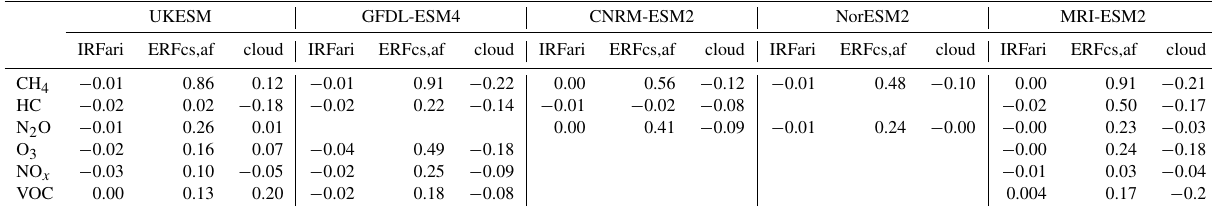
Table 5. Calculations of IRFari, ERFaci (cloud) and ERFcs,af for the chemically reactive species. UKESM GFDL-ESM4 CNRM-ESM2 NorESM2 cloud IRFari ERFcs,af cloud IRFari ERFcs,af cloud IRFari